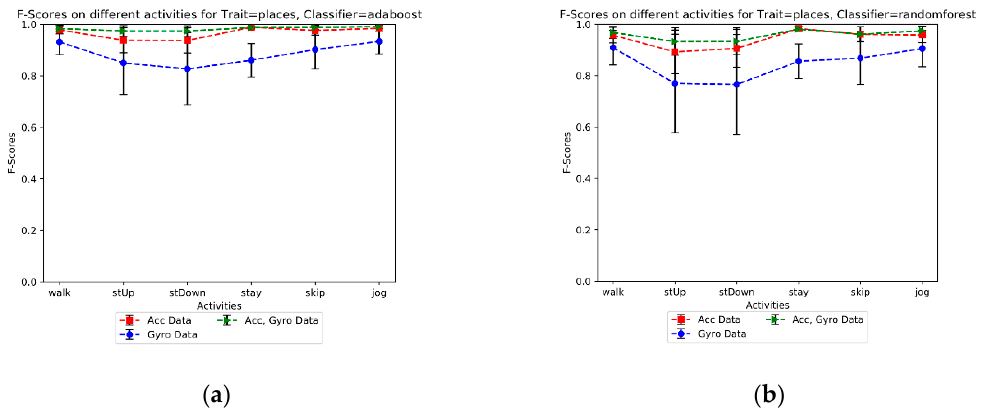
Figure 4. ( a ) F-score of the AdaBoost model’s performance ( b ) F-score of the Random Forest model’s performance.